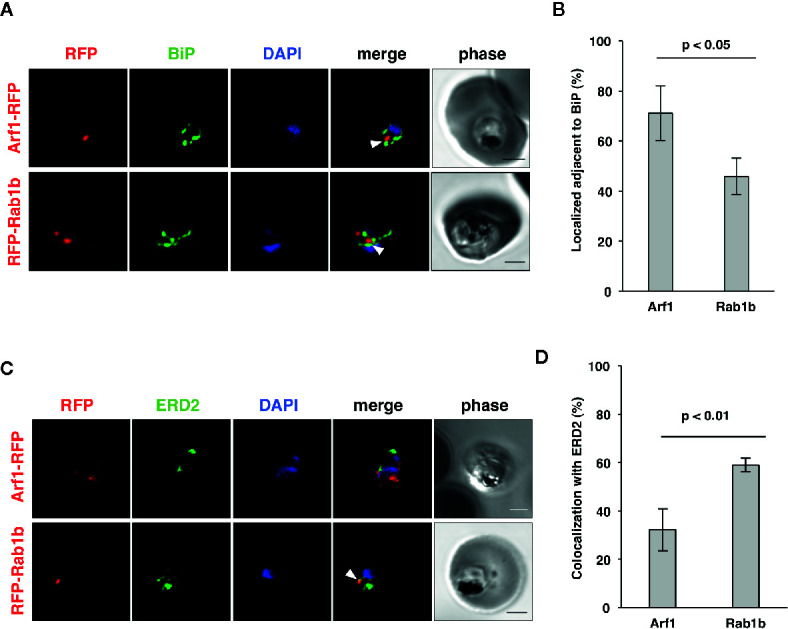
Localization of PfArf1 and PfRab1b in juxtaposition to the ER and the cis-Golgi. (A) Synchronized parasites, expressing PfArf1-RFP (upper, red) or RFP-PfRab1b (lower, red), were fixed at early trophozoite stage and subjected to the indirect immunofluorescence analysis with anti-PfBiP antibody (green) and DAPI (blue). The fluorescence of PfArf1-RFP and RFP-PfRab1b is shown. PfBiP was stained with an anti-PfBiP antibody. Both PfArf1-RFP and RFP-PfRab1b localized adjacent to the PfBiP signal (arrowheads). (B) Rate of colocalization of PfArf1-RFP and RFP-PfRab1b with PfBiP. The number of parasites that showed colocalization of the RFP and PfBiP signals was counted in 20–30 trophozoites from three independent experiments. Error bars indicate the standard deviations of three replicates. A test for statistical significance was performed using the Student t-test. (C) Indirect immunofluorescence analysis of the localization of PfArf1-RFP (upper, red), RFP-PfRab1b (lower, red), the cis-Golgi-marker PfERD2 (green), and DAPI (blue). The fluorescence from RFP-PfRab1b colocalized with the PfERD2 signal (arrowhead), but not with PfArf1-RFP. The bars indicate 2 µm. (D) Rate of colocalization of PfArf1-RFP and RFP-PfRab1b with PfERD2. The number of parasites that showed colocalization of the RFP and PfERD2 signals was counted in 20–30 trophozoites from three independent experiments. A test for statistical significance was performed using the Student t-test.